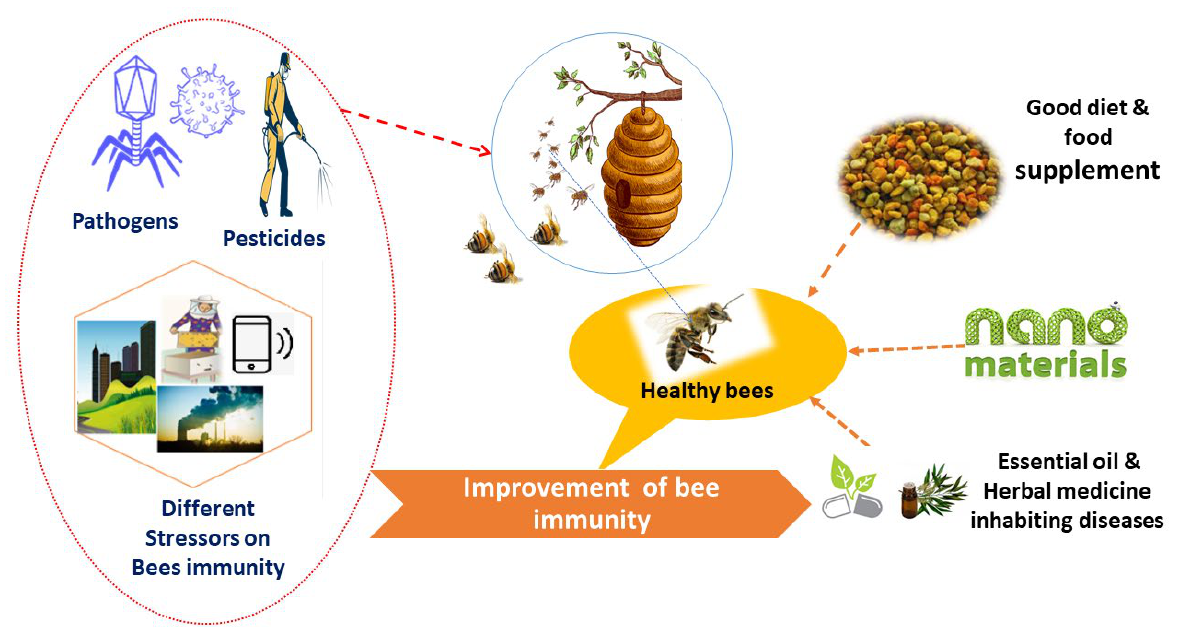
Figure 2. Factors that can improve honeybees immunity against different stressors.